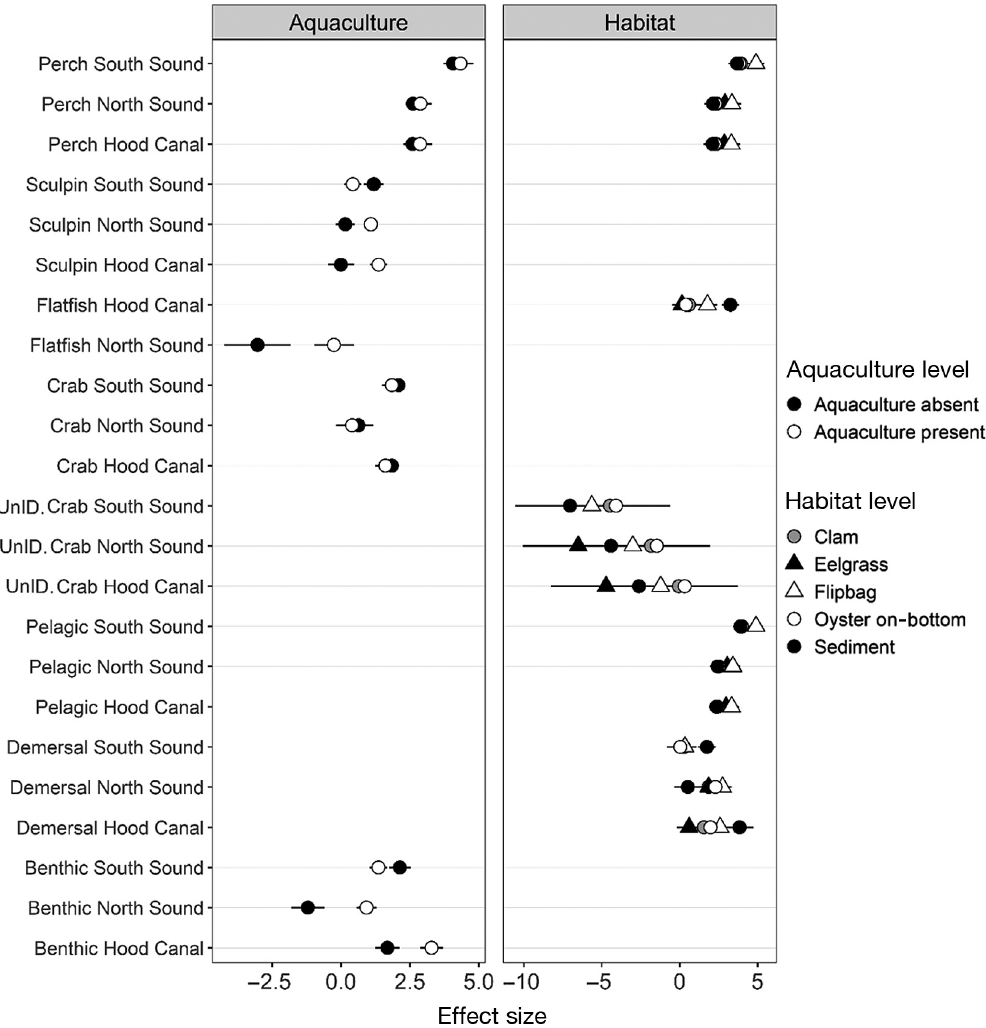
Fig. 6. Estimated effect sizes (SE) from best fit generalized mixed effect linear models that explained observed variation in abundance of surfperch, sculpin, flatfish, crabs, unidentified crabs, and pelagic, demersal, and benthic functional groups. The best fit models include a fixed effect of aquaculture: present (clam, oyster on-bottom, oyster in flipbags) and absent (sediment, eelgrass), or mesohabitat: flipbag, clam, on-bottom, eelgrass, and sediment. All models except flatfish include region (South Sound, North Sound, Hood Canal) as a fixed effect. Flatfish were analyzed separately by region (no model for South Sound. UnID.Crab: unidentified crab